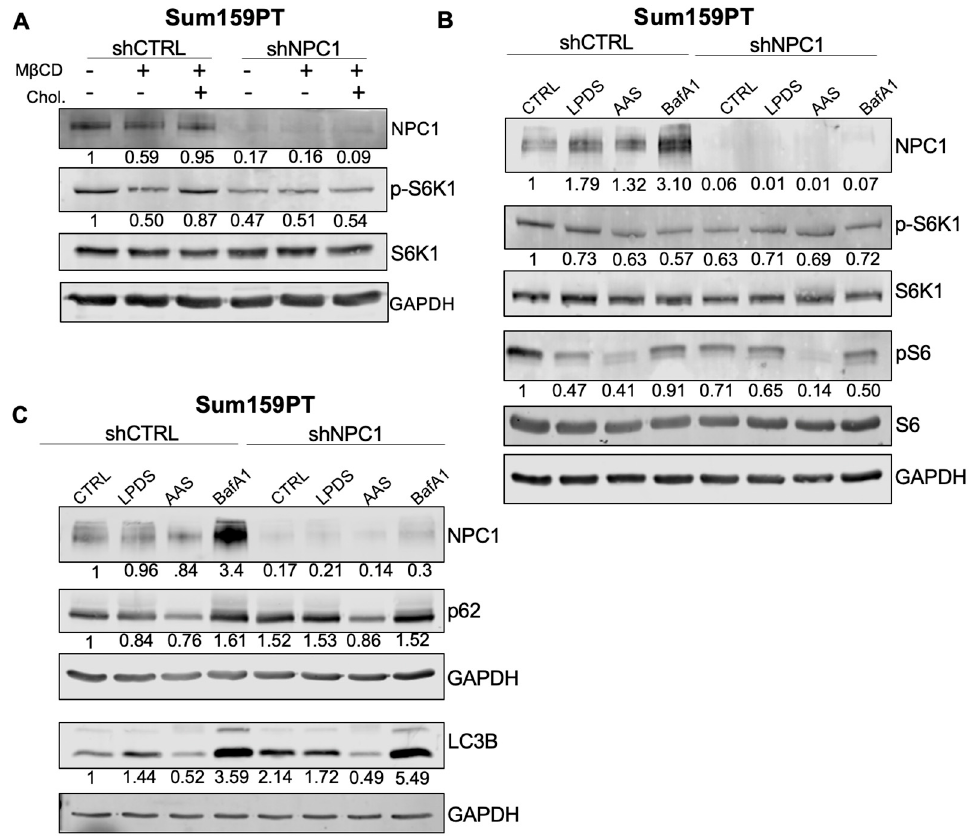
Figure 5. NPC1 affects mTOR and autophagy signaling under stress conditions in TNBC. ( A ) Western pospho-S6K (T389) signaling under cholesterol-stressed conditions. Control cells (lane 1, 4) were maintained in full serum. Where indicated, M β CD is used to deplete cholesterol for 2 h and then, as indicated (lane 3, 6), M β CD is removed and replaced with M β CD:Cholesterol to replenish cholesterol supply. Numbers below pS6K1 represent levels normalized to total S6K1. ( B ) S6 kinase signaling under metabolic or lysosome stress conditions for 24 h (LPDS − 5% lipoprotein depleted serum; AAS-amino acid depletion with 5% FBS; BafA1-5nM). pS6K (Ser235/236) and pS6 are normalized to their total controls. NPC1 is normalized to GAPDH. ( C ) Autophagy markers p62 and LC3B under metabolic or lysosomal stress conditions.